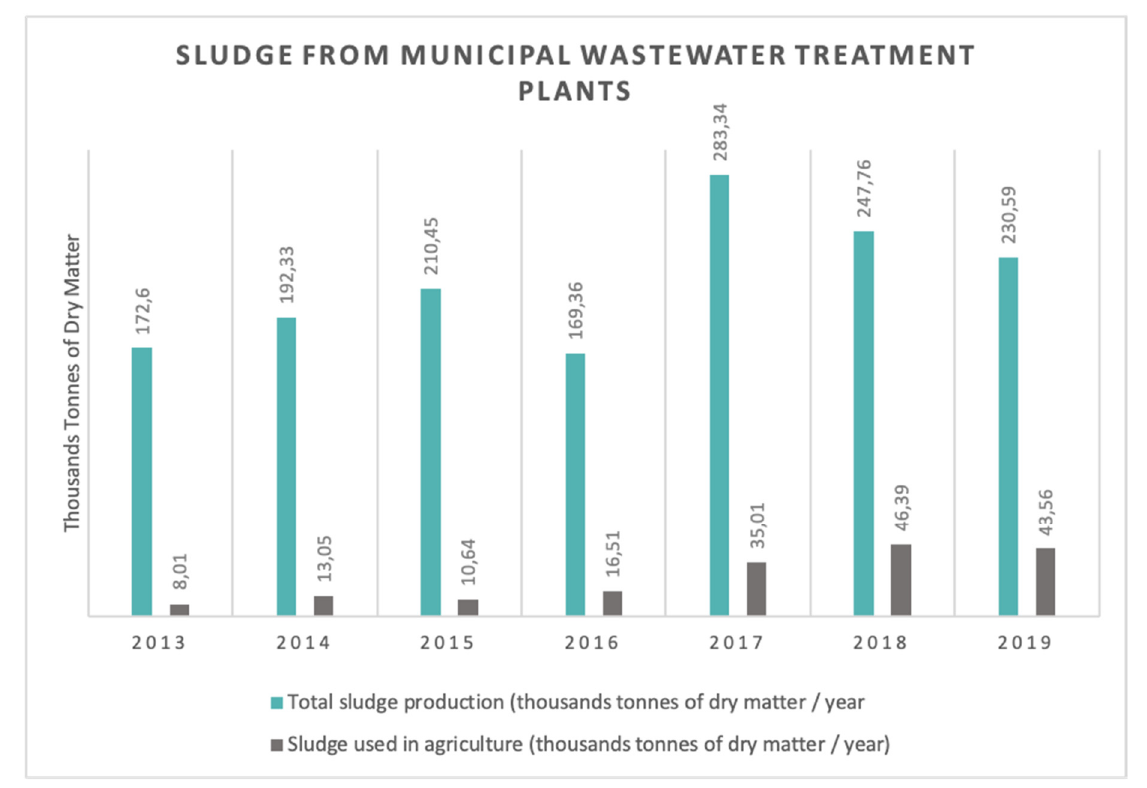
Figure 4. Production of biosolids and their use in agriculture in Romania in 2013–2019. Data source: National Statistics Institute [18].